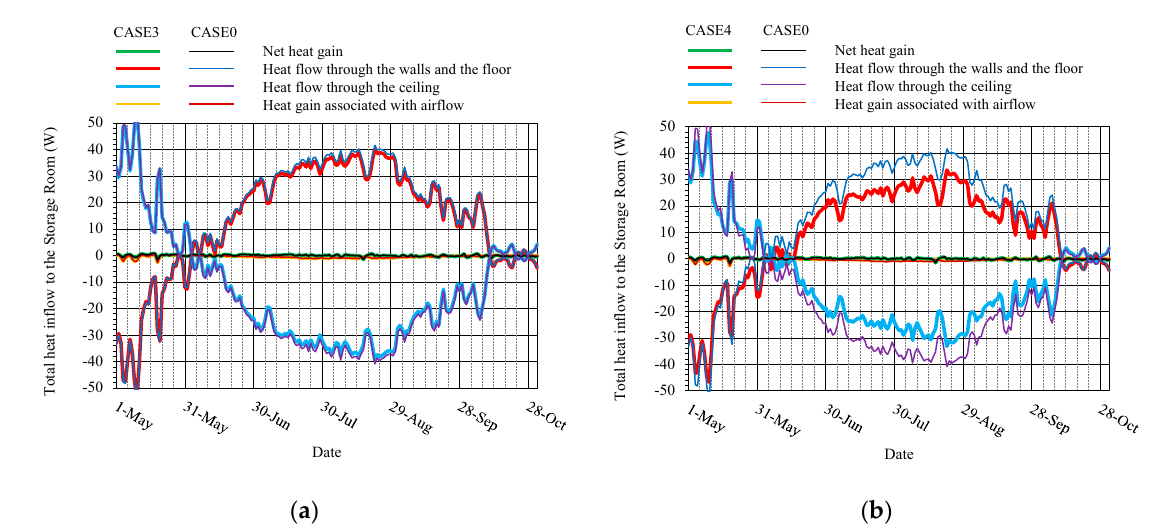
Figure 14. Comparison of the heat flow into the storage room: ( a ) total heat inflow to the storage room in CASES 0 and 3; ( b ) total heat inflow to the storage room in CASES 0 and 4.